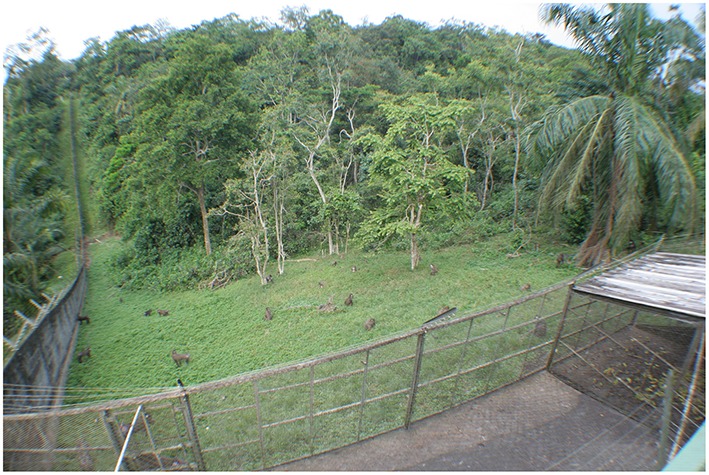
Photograph of the observation area from the tower where observations were realized. Credit Chailleux E.